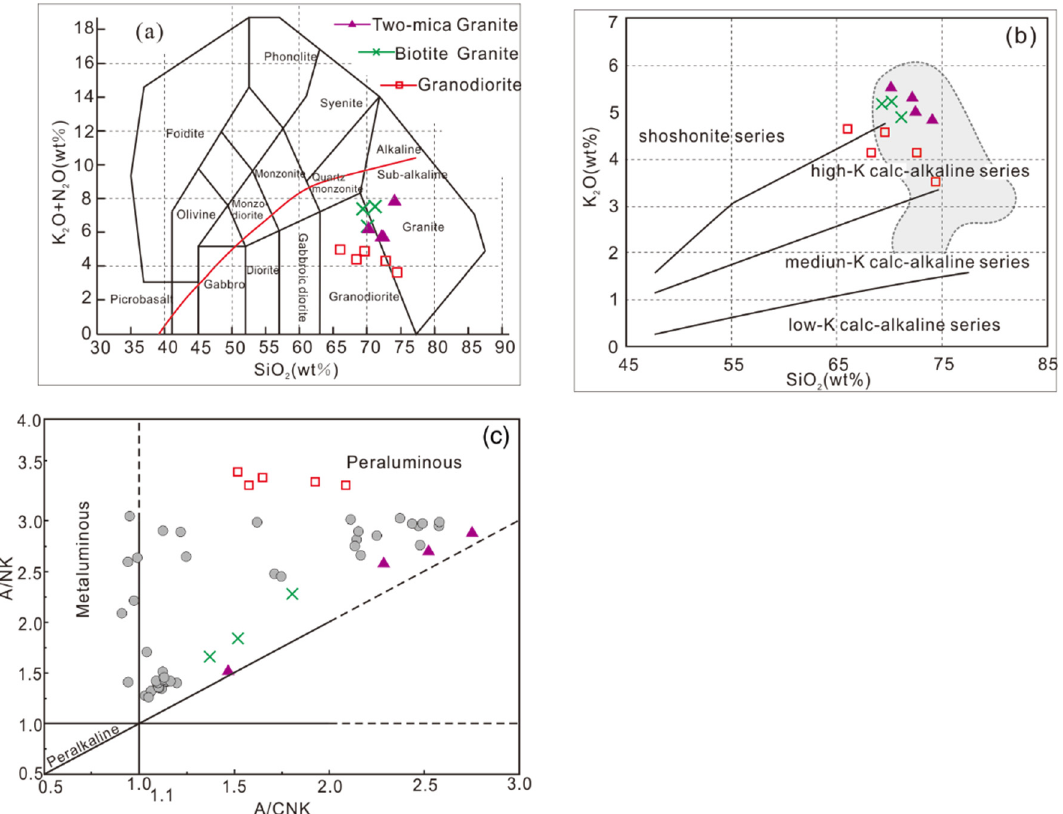
Figure 5. ( a ) Total alkali-silica (TAS) diagram (after [61,62]; ( b ) K 2 O–SiO 2 diagram (after [63]) and ( c ) A/NK–A/CNK diagram (after [64]) for the Zhuxi granites from the Jingdezhen area. The shaded area in ( b ) and circles in ( c ) denote published data for the Zhuxi granites [38,42,43].